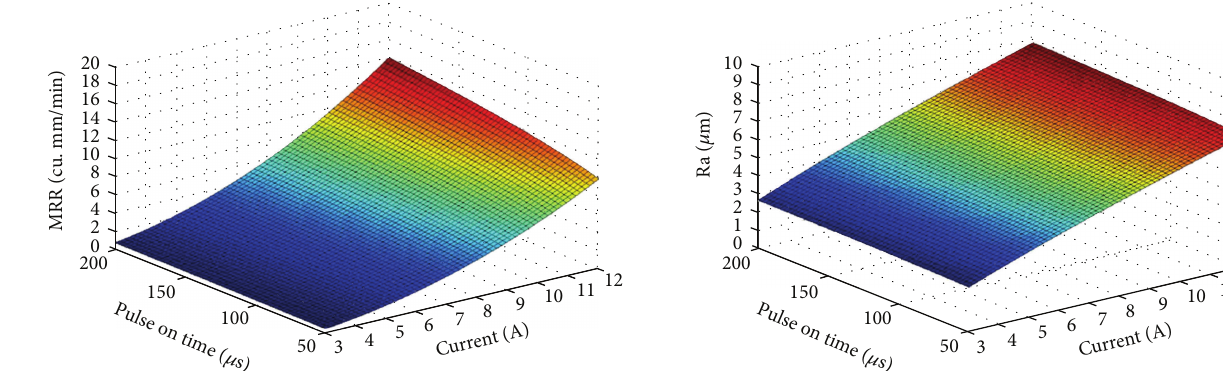
Figure 1: Effect of current and pulse on time on material removal rate (MRR) at pulse off time = 125 𝜇 s.